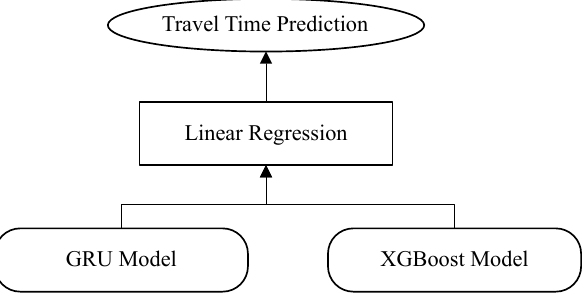
Figure 2. Architecture of Hybrid Models (based on